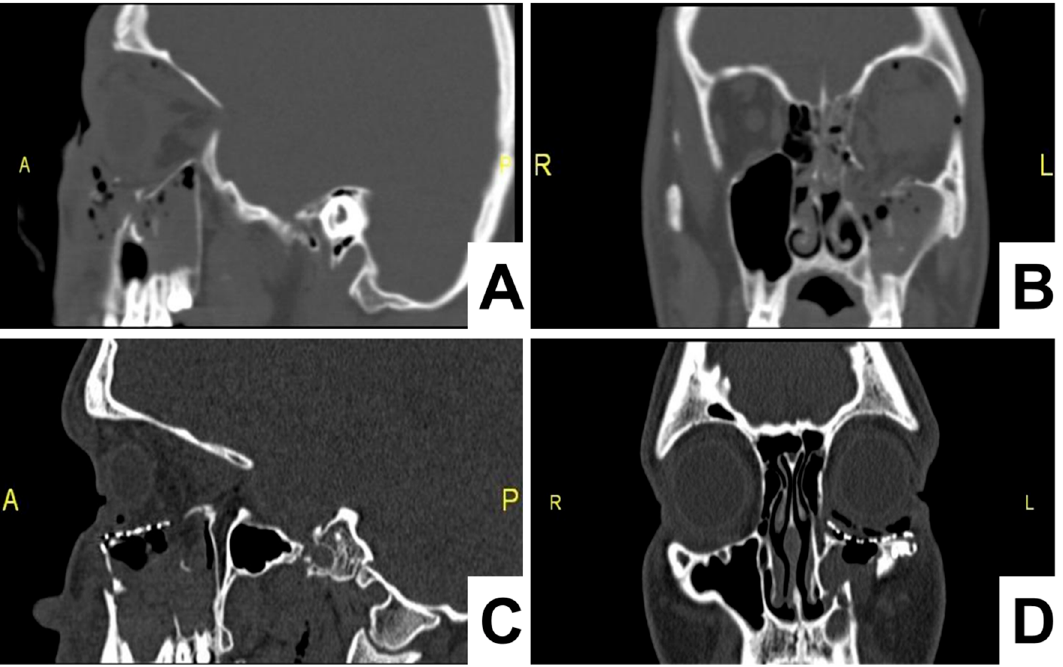
Figure 4. Pre- ( A , B ) and postoperative (next day) ( C , D ) control computer tomography (CT) scan of the eyelids in the patient undergoing orbital floor fracture treatment by a fully covered titanium mesh with collagen membrane. A benefit of the titanium mesh is that it does not present artifacts in CT or magneitc resonance (MR, Magnetic resonance) imaging.